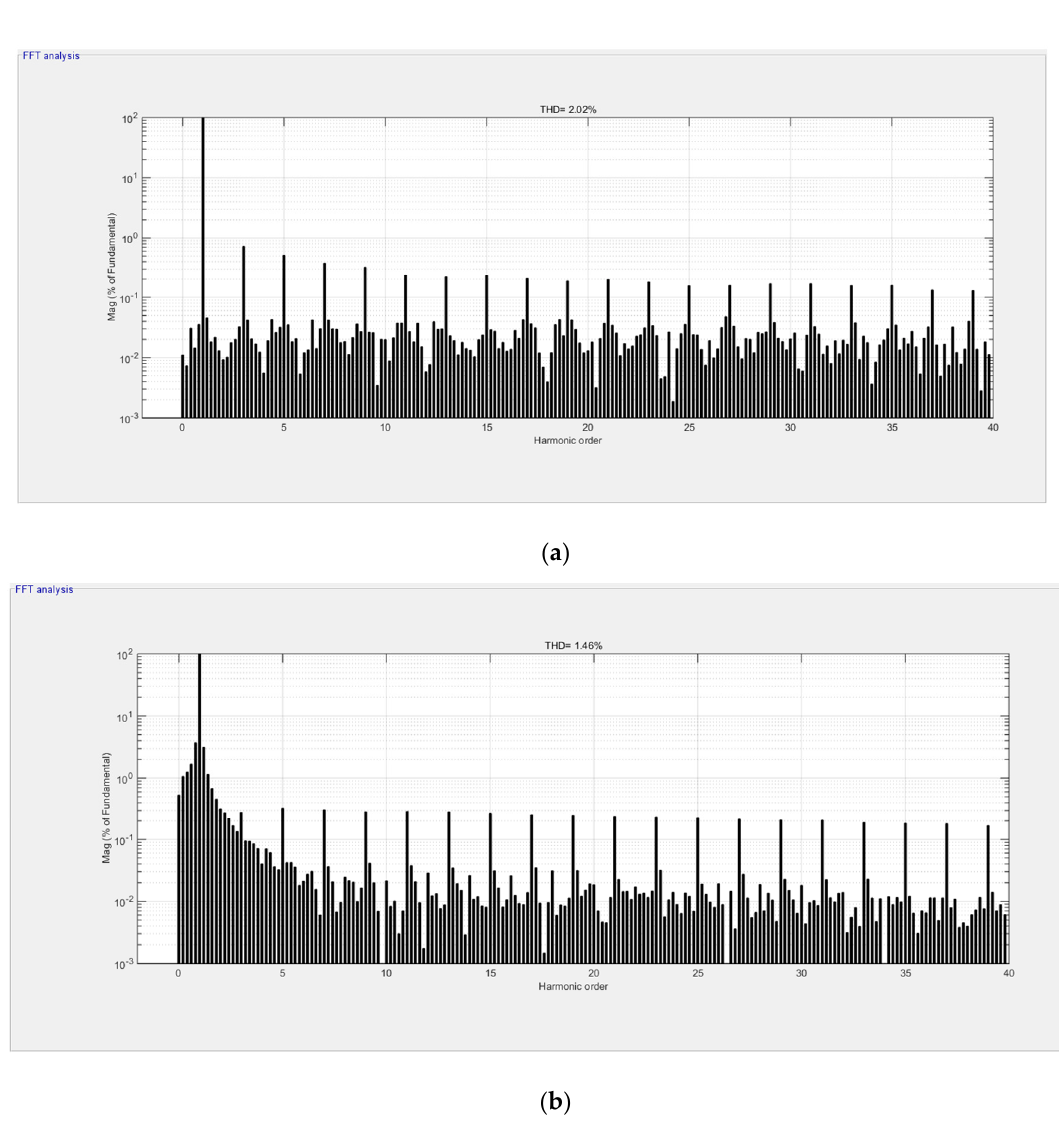
Figure 11. The harmonic spectrum of the ( a ) conventional and ( b ) proposed at 75% insolation.